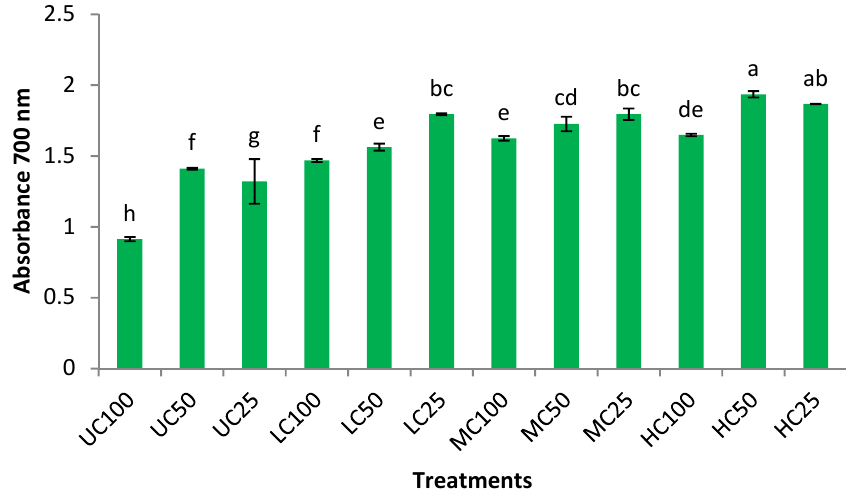
Figure 5. Reducing power of air-fried eggplant. The treatment codes consisting of different letters and digits represent the uncooked (UC), high-cooked (HC), medium-cooked (MC), and low-cooked (LC) eggplant samples extracted with absolute ethanol (100), 50% ethanol (50), and 25% ethanol (25). The bars containing different letters are significantly different from each other ( p < 0.05).